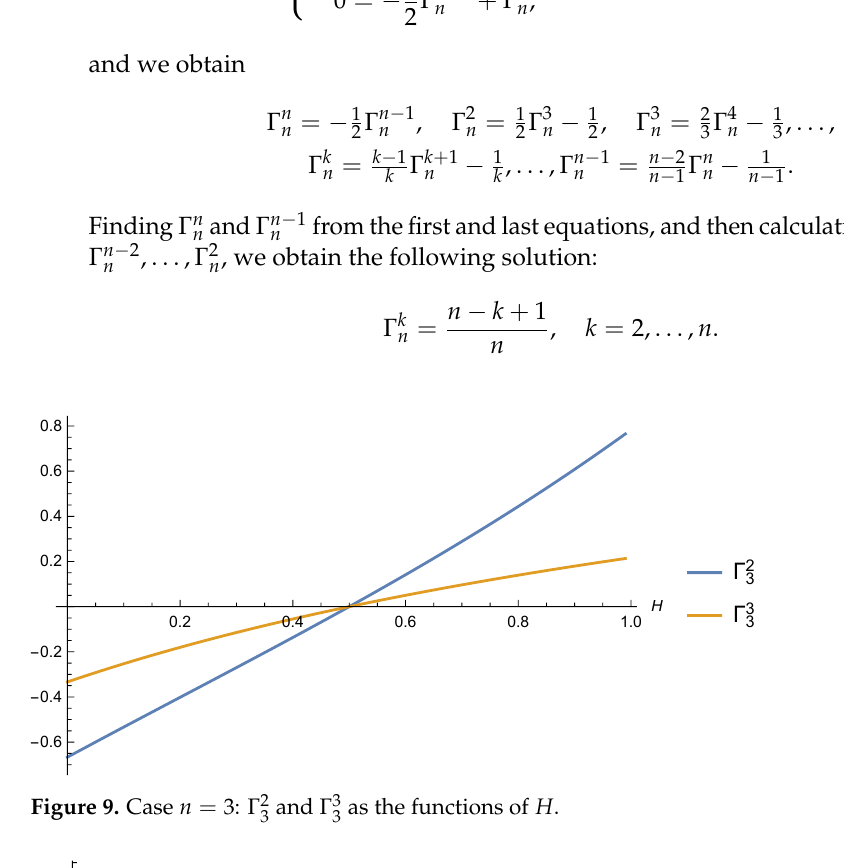
and Γ 3 as the functions of H . 3 3